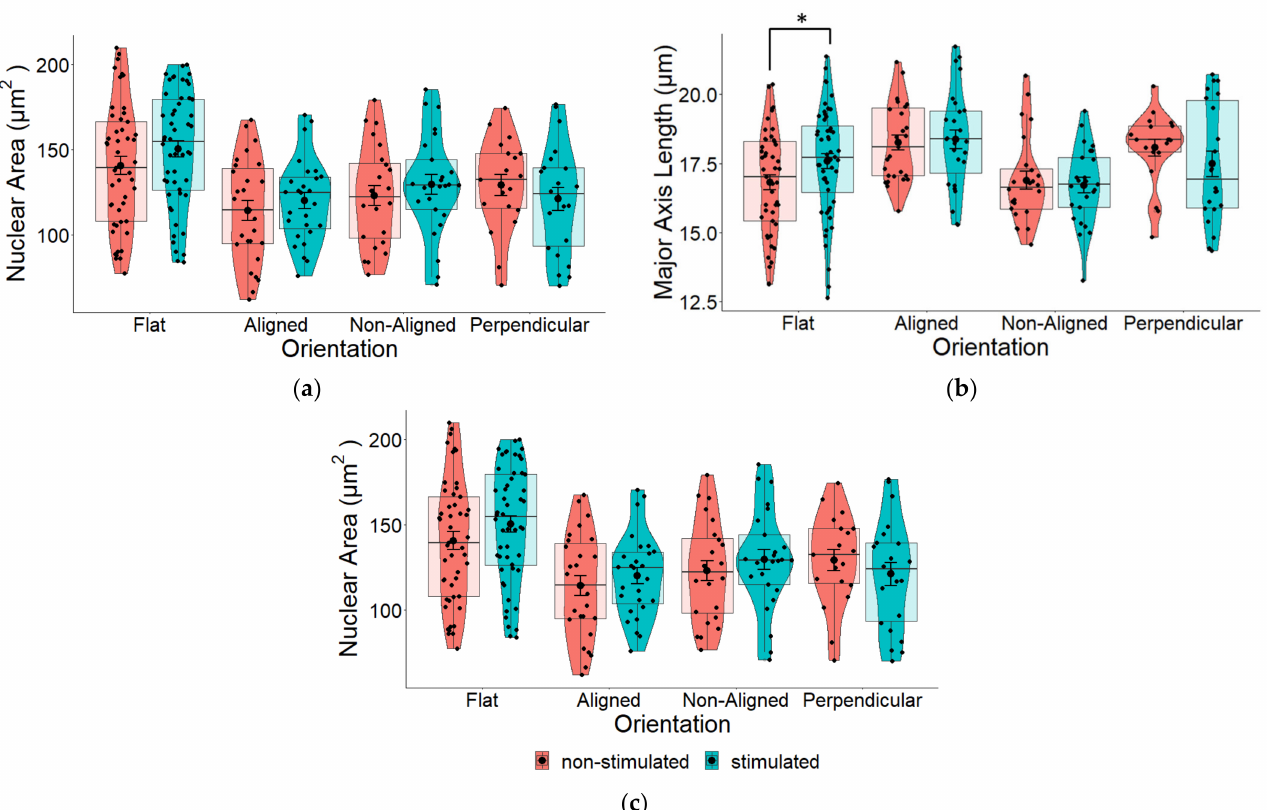
Figure 6. ( a ) Pair-wise comparison of the nuclear area of SH-SY5Y cells grown on aligned or non- aligned scaffolds with (ES—stimulated) and without (Control—non-stimulated) EF. The effect of EF on nuclear area was not significant: one-way ANOVA for the comparison between stimulated and non-stimulated cells on flat substrates p = 0.174, aligned p = 0.433, non-aligned p = 0.441, and perpendicular p = 0.377. ( b ) Pair-wise comparison of nuclear surface area along the major (long) axis of SH-SY5Y cells with (ES) and without (Control) EF. One-way ANOVA for the comparison between stimulated and non-stimulated cells: p = 0.046 (flat), p = 0.795 (aligned), p = 0.567 (non-aligned), and p = 0.313 (perpendicular). * p < 0.05. ( c ) Pair-wise comparison of nuclear surface area along the minor (short) axis of SH-SY5Y cells with (ES) and without (Control) EF. One-way ANOVA for the comparison between stimulated and non-stimulated cells: p = 0.344 (flat), p = 0.225 (aligned), p = 0.382 (non-aligned), p = 0.454 (perpendicular). Flat n = 101, aligned n = 54, non-aligned n = 49, perpendicular n =